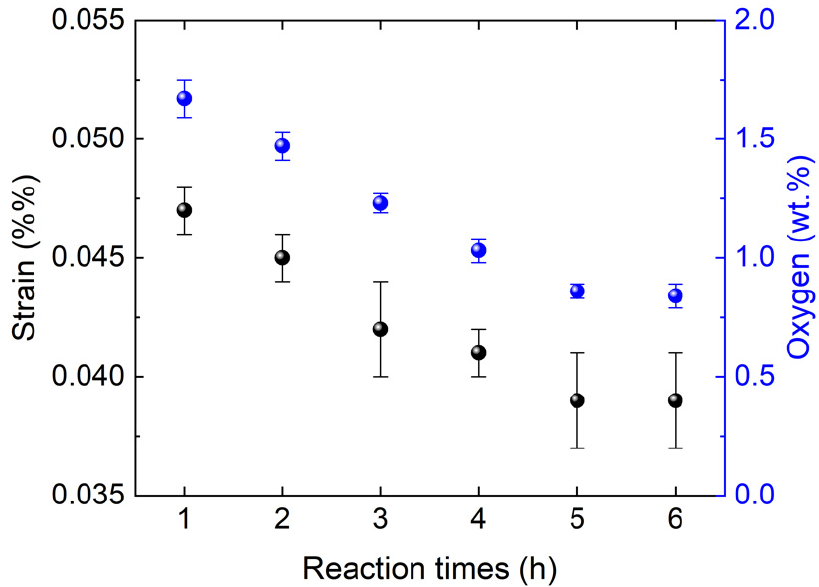
Figure 4. Changes in strain and residual oxygen concentration AlN lattice with reaction time.